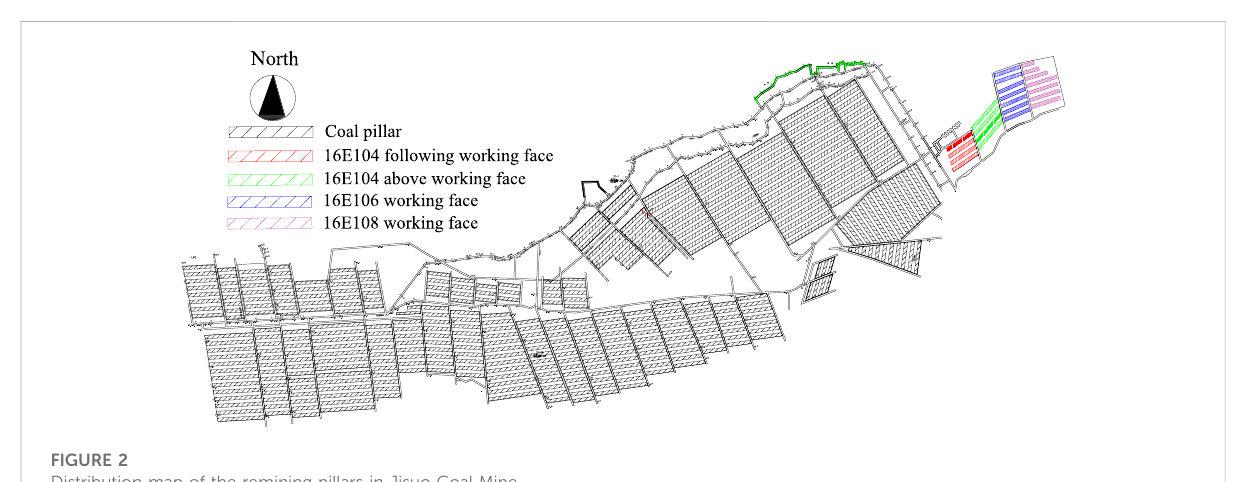
FIGURE 1 Mine location.